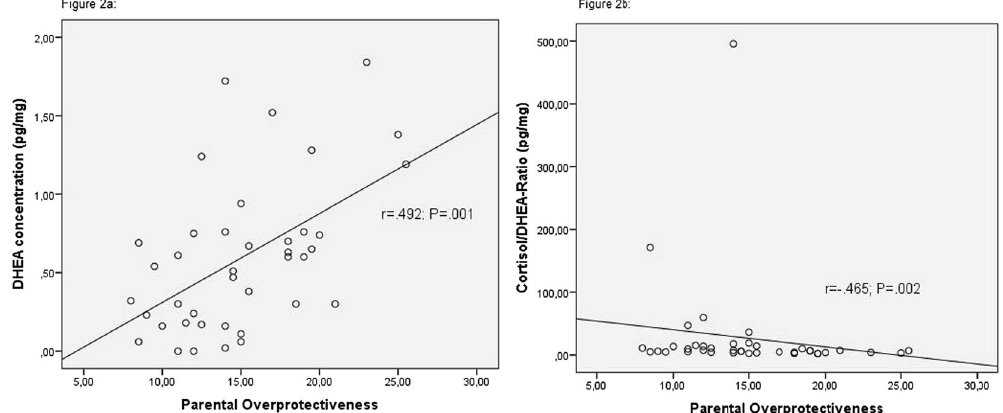
Figure 2. Spearman’s correlations between parental child rearing practices and the long-term LHPA axis activity. Figure 2a shows Spearman’s correlations between dehydroepiandrostendione (DHEA) concentrations and parental overprotecting. Figure 2b shows Spearman’s correlations between cortisol/DHEA-ratio and parental overprotecting. Cortisol/DHEA-ratio was calculated by using the concentrations of cortisol and DHEA in 3 cm hair segments. The level of “parental overprotecting” was generated by using the mean-values of maternal and paternal parental overprotecting of the Recalled Parental Rearing Behavior Questionnaire (FEE).